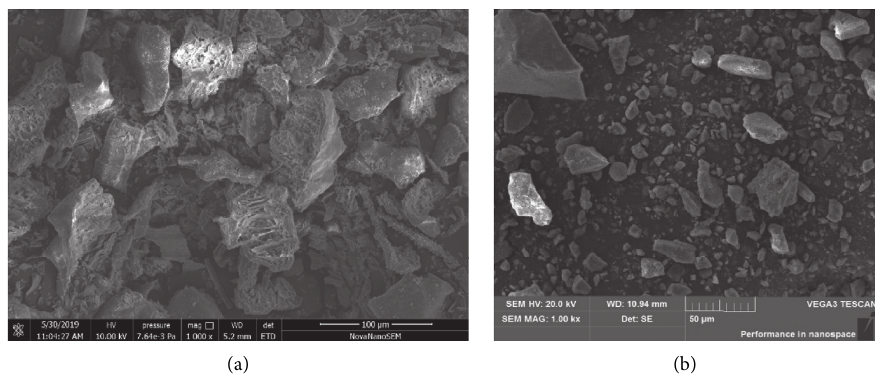
Figure 2: SEM images of (a) biochar and (b) granite filler.